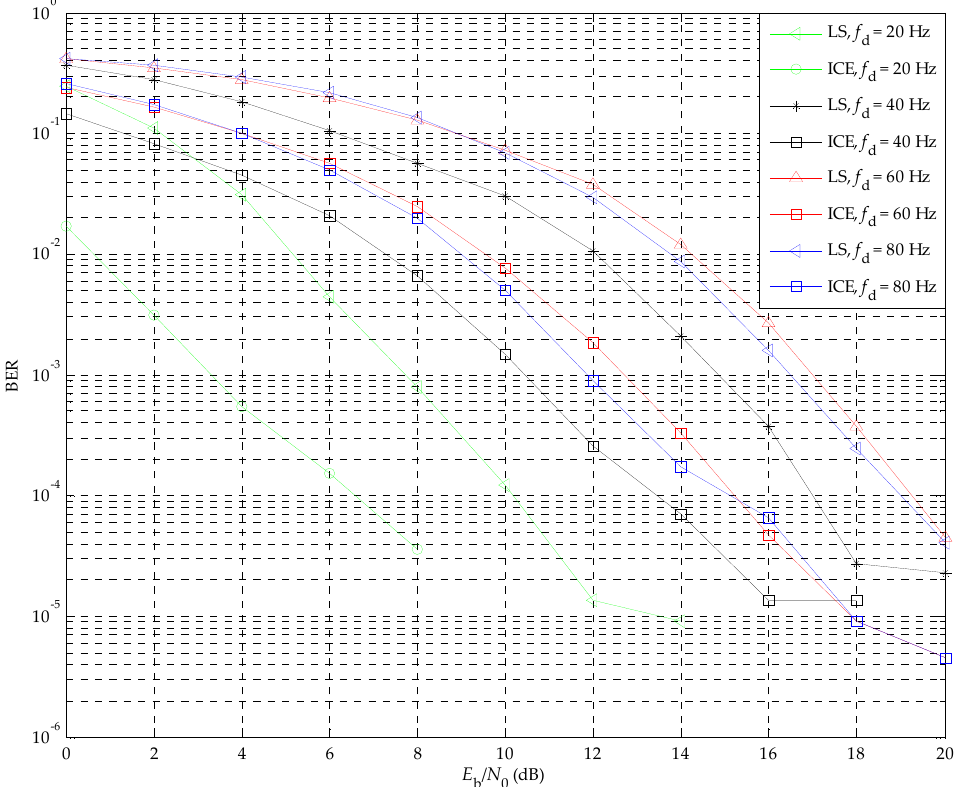
Figure 6. BER performance of the OFDM/QPSK system over Rayleigh fading channels with Doppler spread of 20, 40, 60, and 80 Hz. LS: least square.